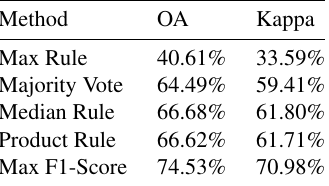
Table 1. Comparison of different strategies of integrating DCRF posterior probabilities to produce an optimal classification